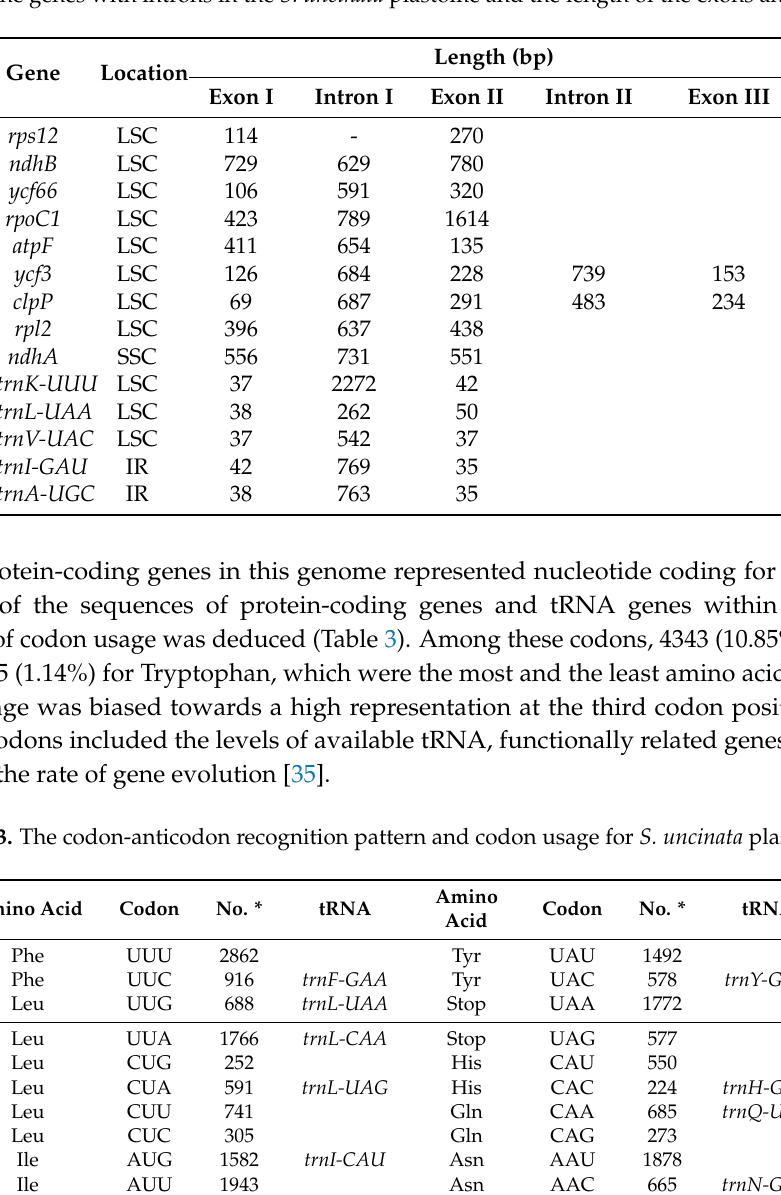
Table 2. The genes with introns in the S. uncinata plastome and the length of the exons and introns. Length (bp) Gene Location Exon I Intron I Exon II Intron II